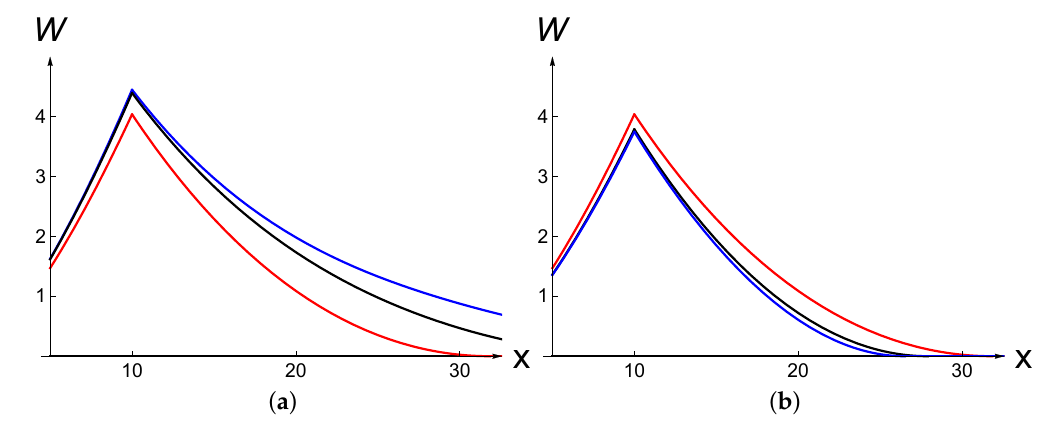
Figure 5. The value of waiting W ( x ) = V ( x ) − ( x − K 1 ) + w.r.t. x for different values of λ . The parameter set is r = δ = 0.03, σ = 0.3, K 1 = 10, K 2 = K 1 ( 1 + γ ) , γ = ± 0.2. ( a ) left: λ = 0 (red line), λ = 0.2 (black line), λ = 0.4 (blue line) when γ = − 0.2; ( b ) right: λ = 0 (red line), λ = 0.2 (black line), λ = 0.4 (blue line) when γ = 0.2.